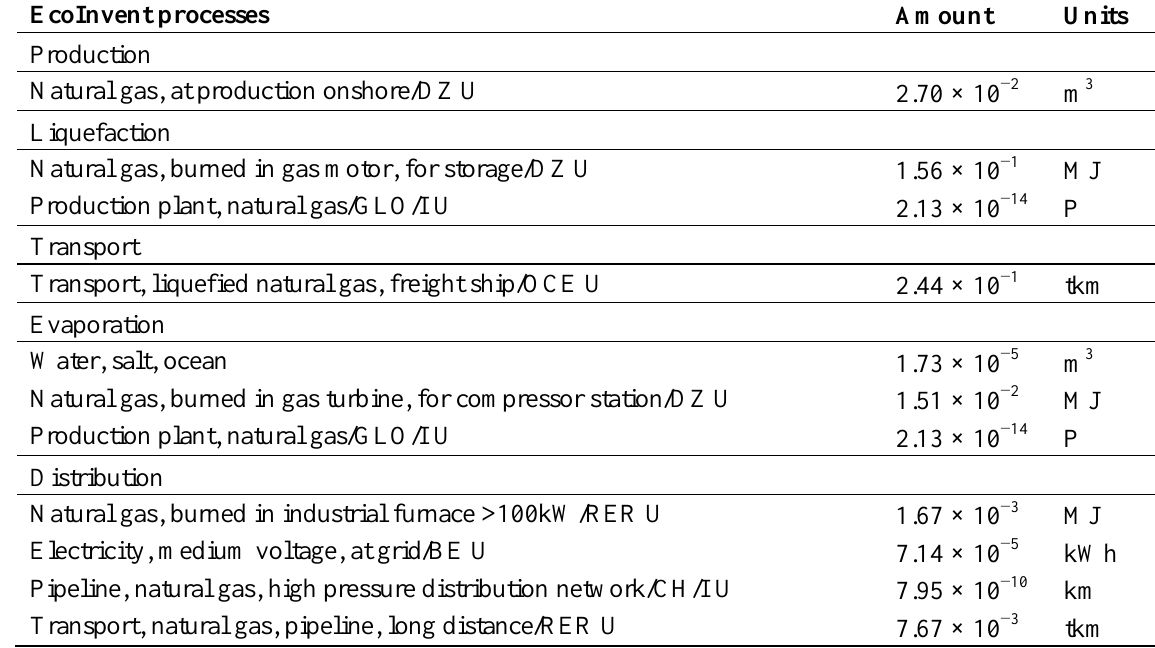
Table 3. Production, transport and evaporation data of 1 MJ of the LNG.